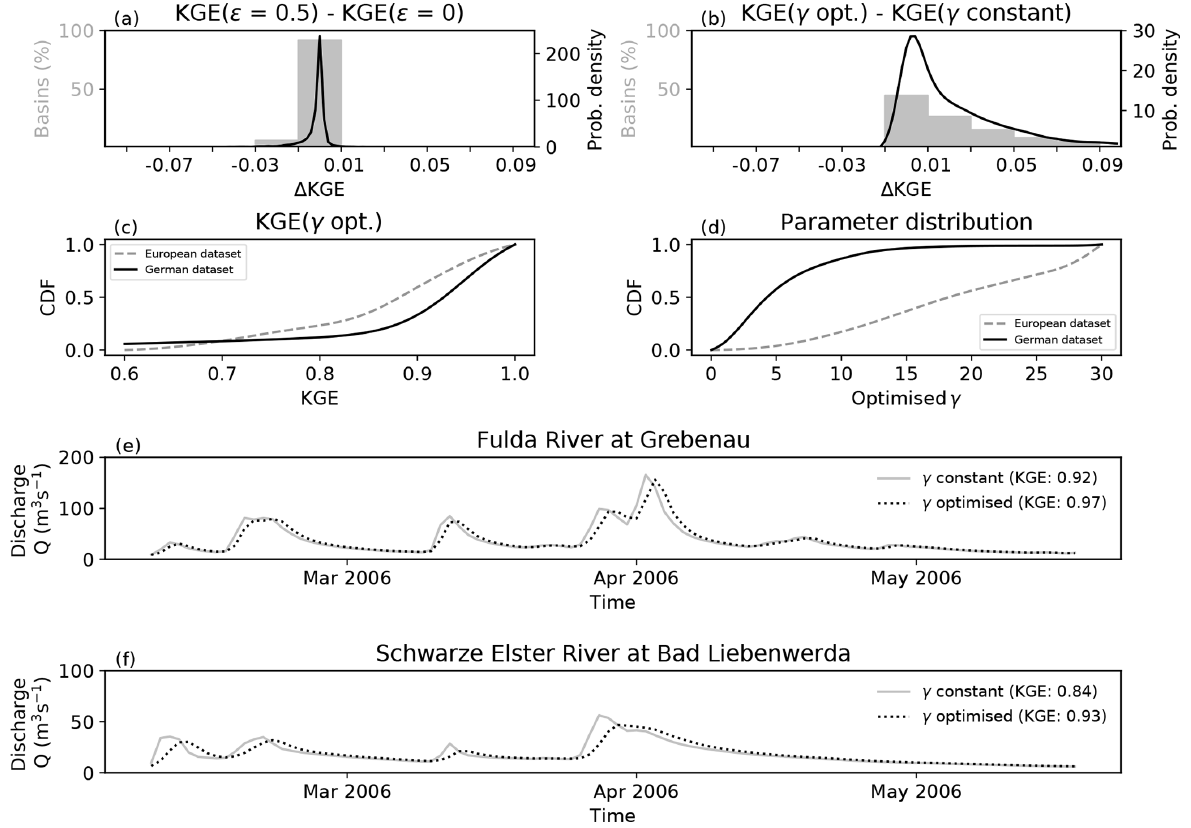
Figure 3. (a) Differences in KGE values between no numeric diffusion ( (cid:15) = 0 . 5) and full numeric diffusion ( (cid:15) = 0) for the combined European and German datasets, and textbf(b) differences in KGE values between model runs with optimised parameter values at each gauge and one constant parameter for all gauges. Probability density functions (PDFs) are shown as black lines. The integrals of the PDFs over intervals of 0.02 (e.g. − 0 . 01 to 0.01) are shown as grey bars normalised with respect to all basins. (c) Cumulative distribution functions (CDFs) of Kling–Gupta efficiencies (KGEs) for the European and German datasets separately based on optimised parameters γ . (d) CDFs of optimised γ for the two datasets. The underlying data shown in panels (a) – (d) are pooled for all catchments and all resolutions. Panels (e) and (f) show the hydrographs for two catchments at 4km resolution for a parameter value of γ = 15 (solid grey line) and the optimised value (dashed black line).